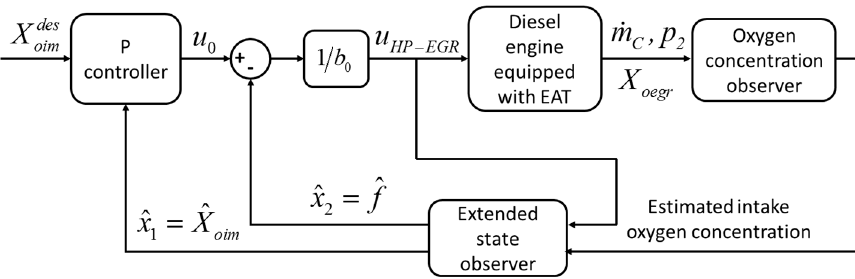
Figure 12. Control structure of the OADRC controller.